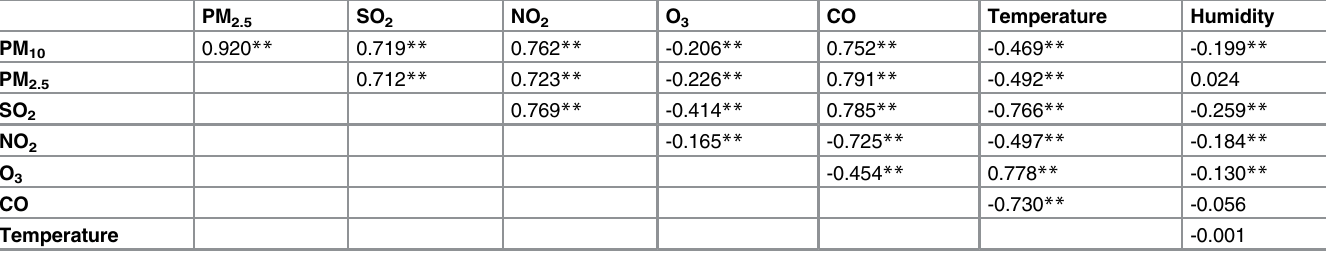
be stronger than those on adult (aged 18 – 59) and elderly (aged > 59) groups. In contrast, the effect tended to be strongest in adult group (aged 18 – 59) for O nificant effect of air pollutants on elderly group. Table 2. Spearman correlation coefficients between daily air pollutant concentrations and weather conditions. PM